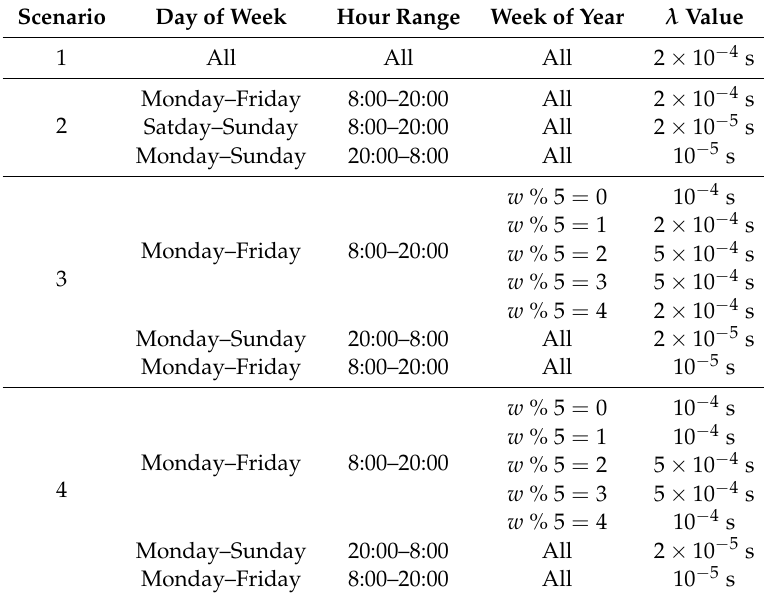
Table 1. Poisson process of job arrivals in each scenario.